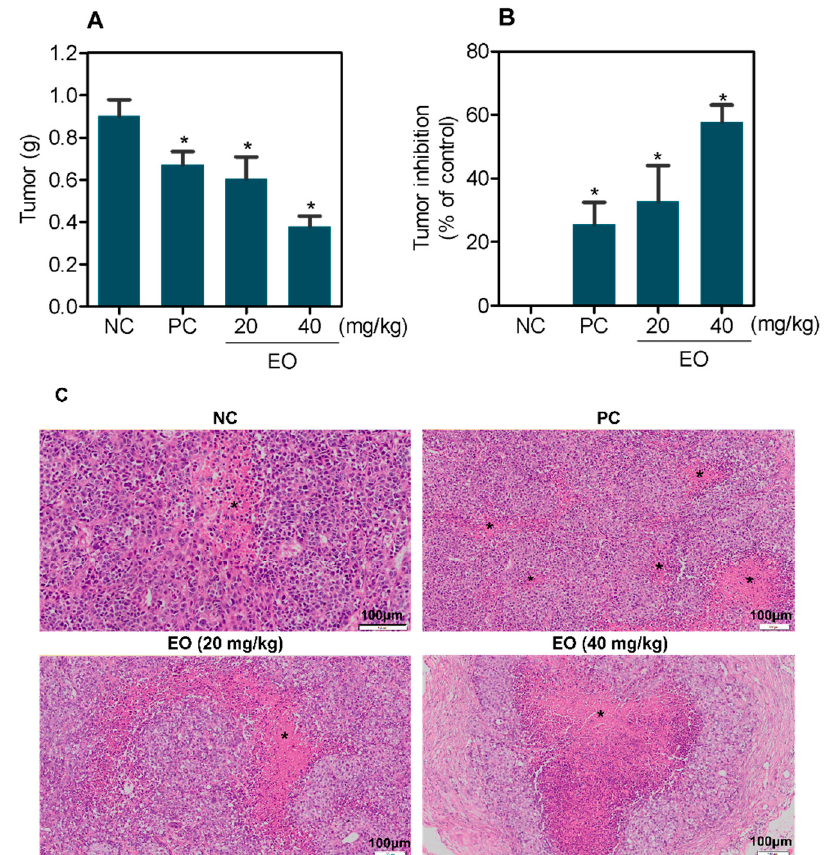
Figure 5. In vivo anti-liver cancer effect of G. olivacea leaf EO in C.B-17 SCID mice with HepG2 cell xenografts. ( A ) Tumor weight (g) after treatment. ( B ) Tumor inhibition (%) after treatment. ( C ) Representative photomicrographs of HepG2 tumors, stained with hematoxylin and eosin and analyzed by light microscopy. Asterisks represent areas of tissue necrosis. Negative control ( NC ) was treated with vehicle (5% DMSO) used for diluting EO, and doxorubicin (0.8 mg/kg) was used as positive control ( PC ). Data are presented as mean ± S.E.M. of 8–17 animals. * p < 0.05 compared with negative control by ANOVA, followed by Student–Newman–Keuls test.